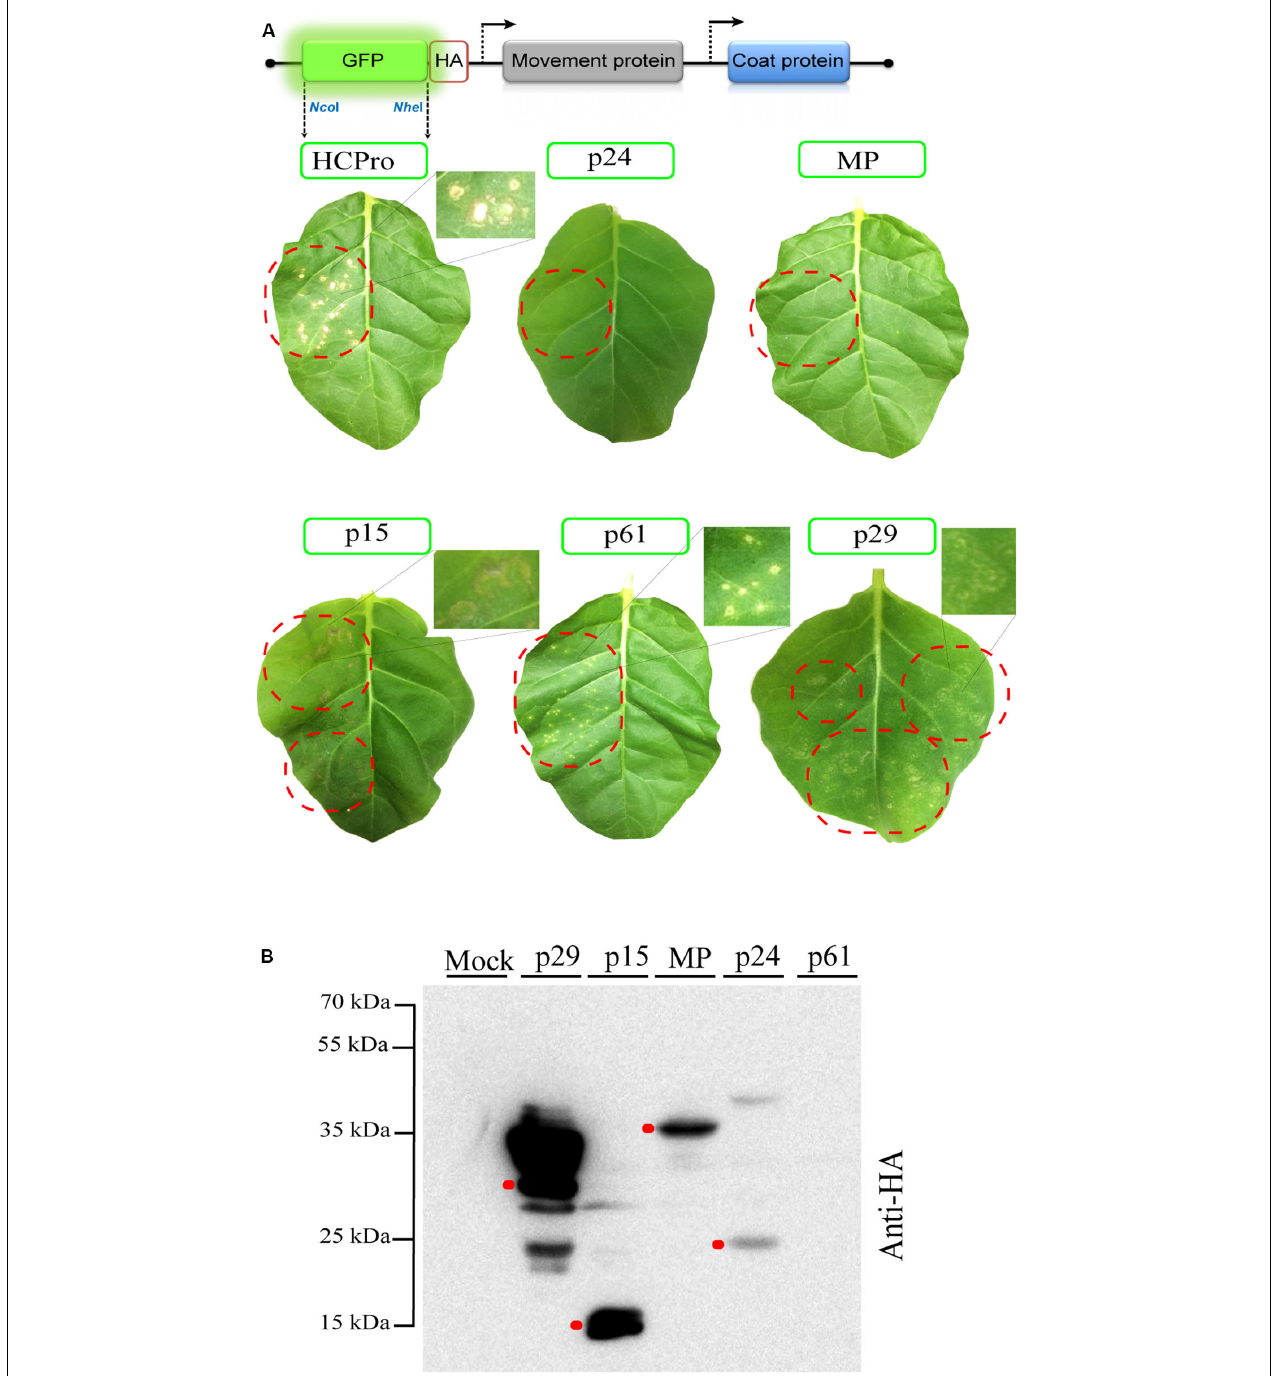
FIGURE 2 | The p29, p15, and p61 proteins trigger necrotic response in P12 Nicotiana tabacum leaves. (A) Inoculation of P12 leaves with the AMV RNA 3 derivative in which its GFP gene was exchanged by the tobacco etch virus HCPro and CiLV-C ORFs (p29, p15, p61, MP, and P24) fused at their C-terminal with the HA epitope. The schematic representation shows the GFP:HA/MP/CP AMV RNA 3, in which the open reading frames corresponding to the green fluorescent protein (GFP), the movement protein (MP), and the coat protein (CP) are represented by large boxes. Short red box corresponds to the HA epitope, meanwhile arrows represent subgenomic promoters. The Nco I and Nhe I restriction sites used for insertions of the assayed proteins are indicated. Necrotic response is observed in leaves inoculated with AMV RNA 3 construction expressing the HCPro (positive control), p29, p15, and p61 proteins at 4 days post-inoculation. The dotted red circles indicate the region of viral transcript inoculation. High magnification shows the necrotic lesions. Three independent experiments were performed, each one included the inoculation of three plants per construct; (B) Western blot analysis of the accumulation of proteins carrying the HA epitope in P12 leaves at 3 dpi. Red dots indicate the corresponding band for each